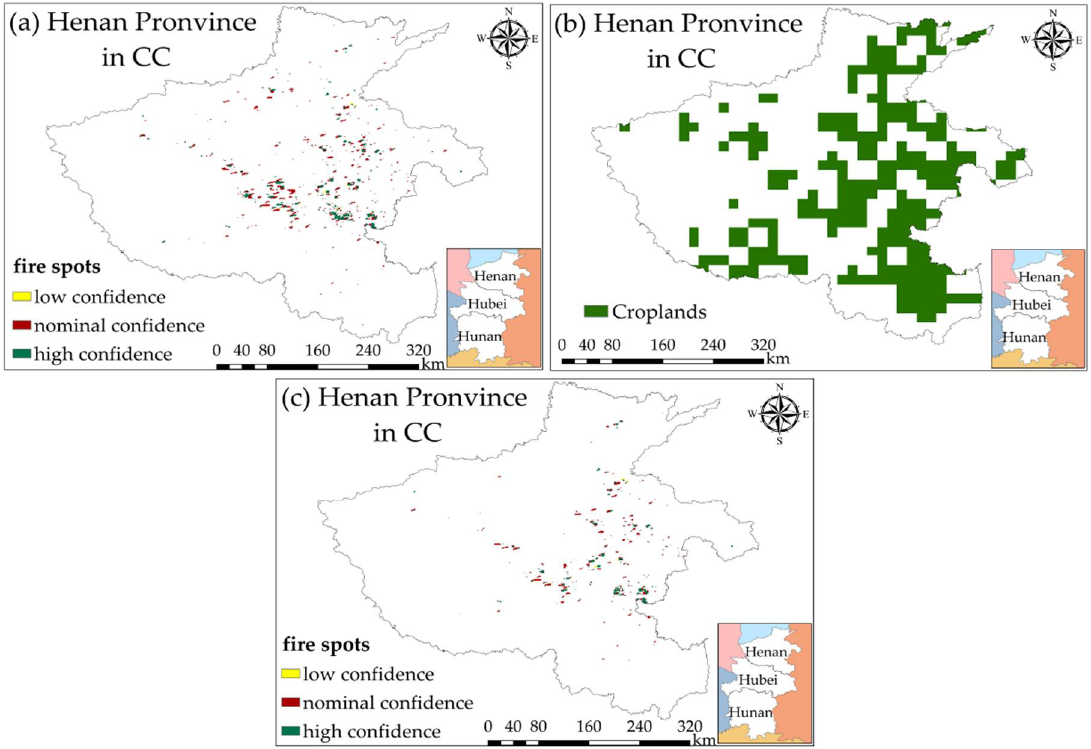
Figure 3. Extraction of crop residue burning spots in China. ( a ) Fire spots extracted from Moderate Resolution Imaging Spectroradiometer (MODIS) fire products; ( b ) Croplands extracted from Land-Use and Land-Cover Change (LUCC) dataset in 2015; ( c ) Crop residue burning spots extracted by combining MODIS fire products and LUCC dataset.